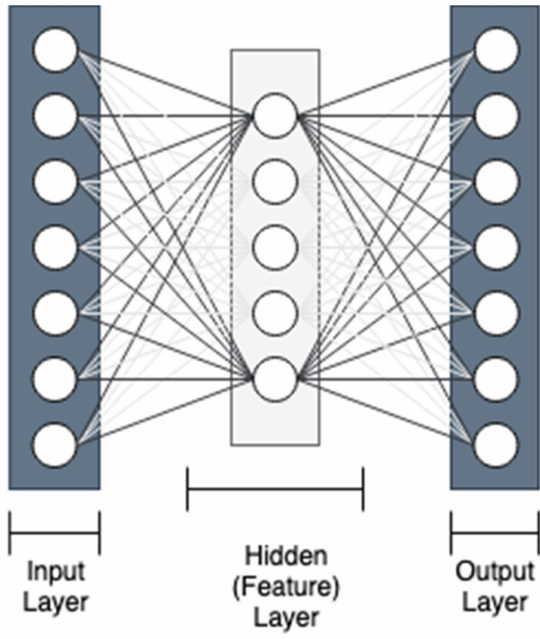
Figure 6. AutoEncoder AE architecture.